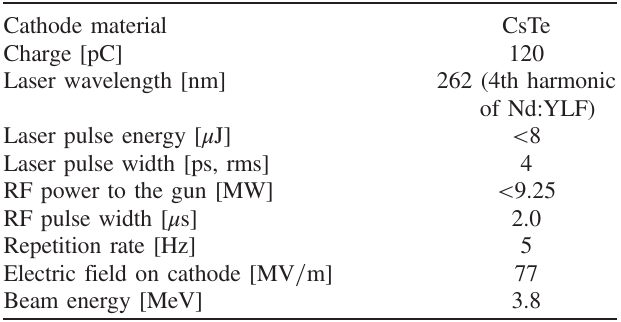
TABLE I. Parameters of the experimental condition.